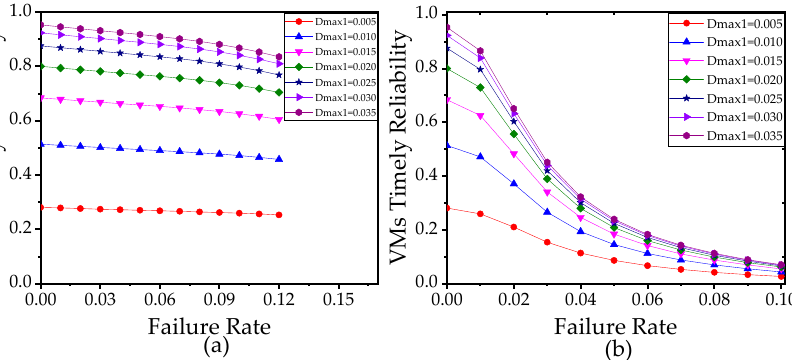
Figure 11. ( a ) VTR versus the failure rate with different maximum allowable edge delay D max 1 , when the migration rate α = 0.002, the reboot rate β = 100 α . ( b ) VTR versus the failure rate with different D max 1 , when the migration rate α = 0.002, the reboot rate β = 100 α . In ( a , b ), the number of sensors is 10, the failure rate of VMs θ = 0.0002. The other parameters used in ( a , b ) refer to Table 3.